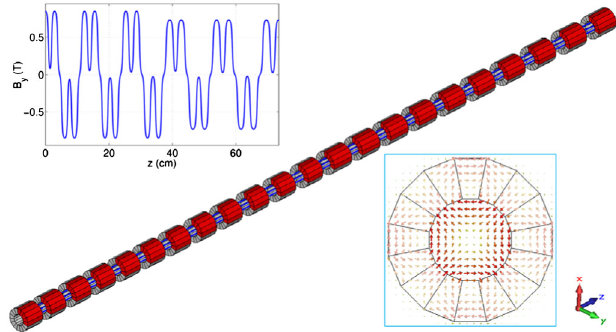
FIG. 18. Array of 22 PMQs in the IH-PMQ tank and their magnetic fields calculated by CST EMS.